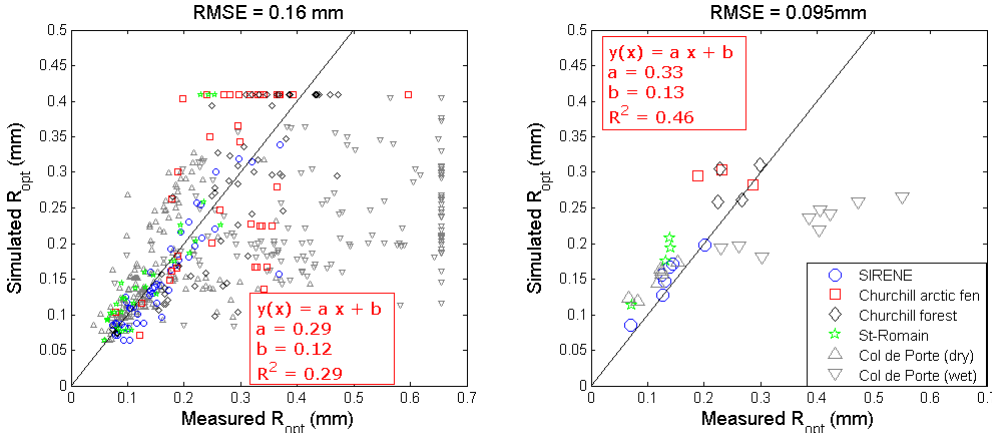
Fig. 10. Measured vs. simulated R opt derived from SSA (Eq. 1) comparison (left panel shows all points; right panel shows the one-layer average). The RMSE in averaged R opt (right panel) without the wet points is 0.043mm.